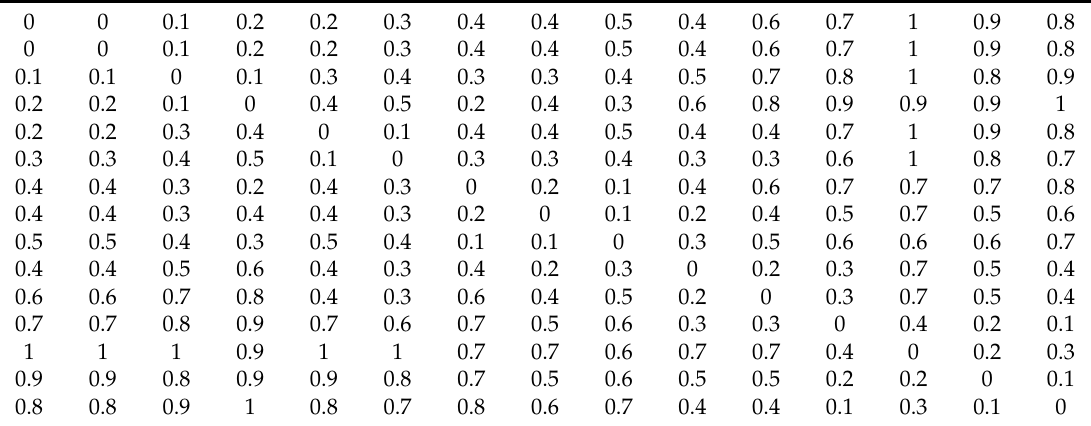
Table A2. Artificial functional distinctness matrix for the 15 species in Table